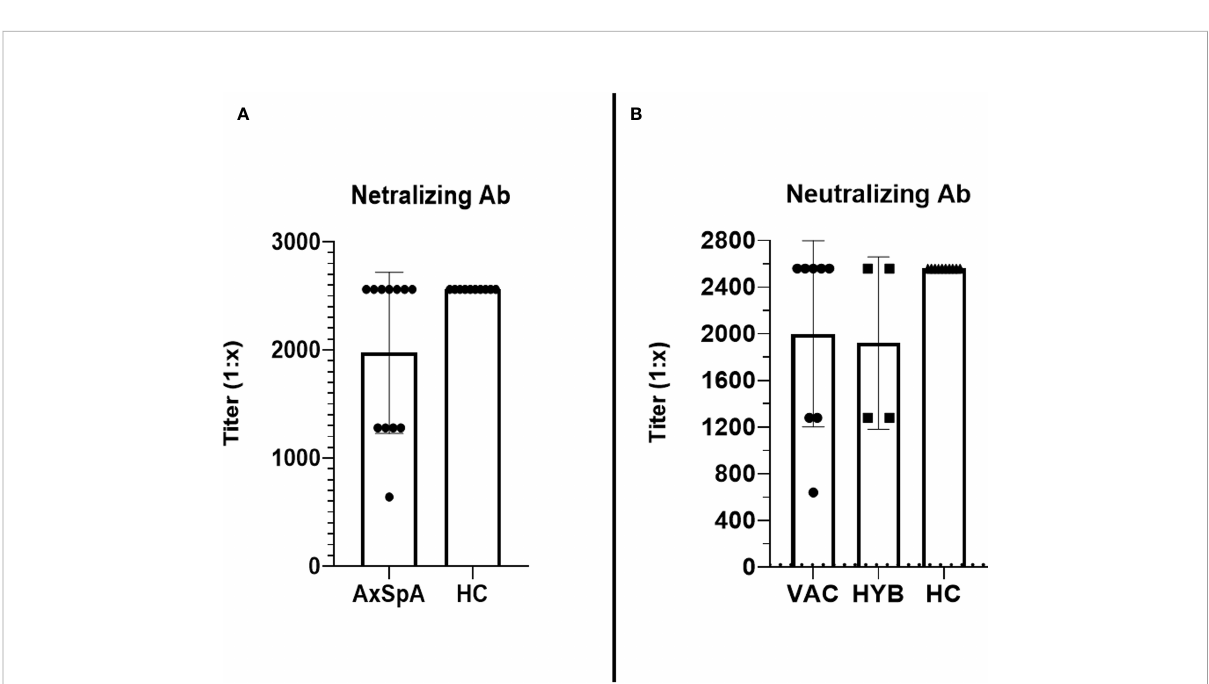
FIGURE 3 The comparison of the titers (reaching from 1:10 to 1:2560) of virus-neutralizing antibodies between Axial spondyloarthritis (AxSpA) and healthy control (HC) cohorts (A) , “ vaccinated only ” and “ hybrid immunity ” AxSpA subgroups (B) ; no statistically signi fi cant differences found between